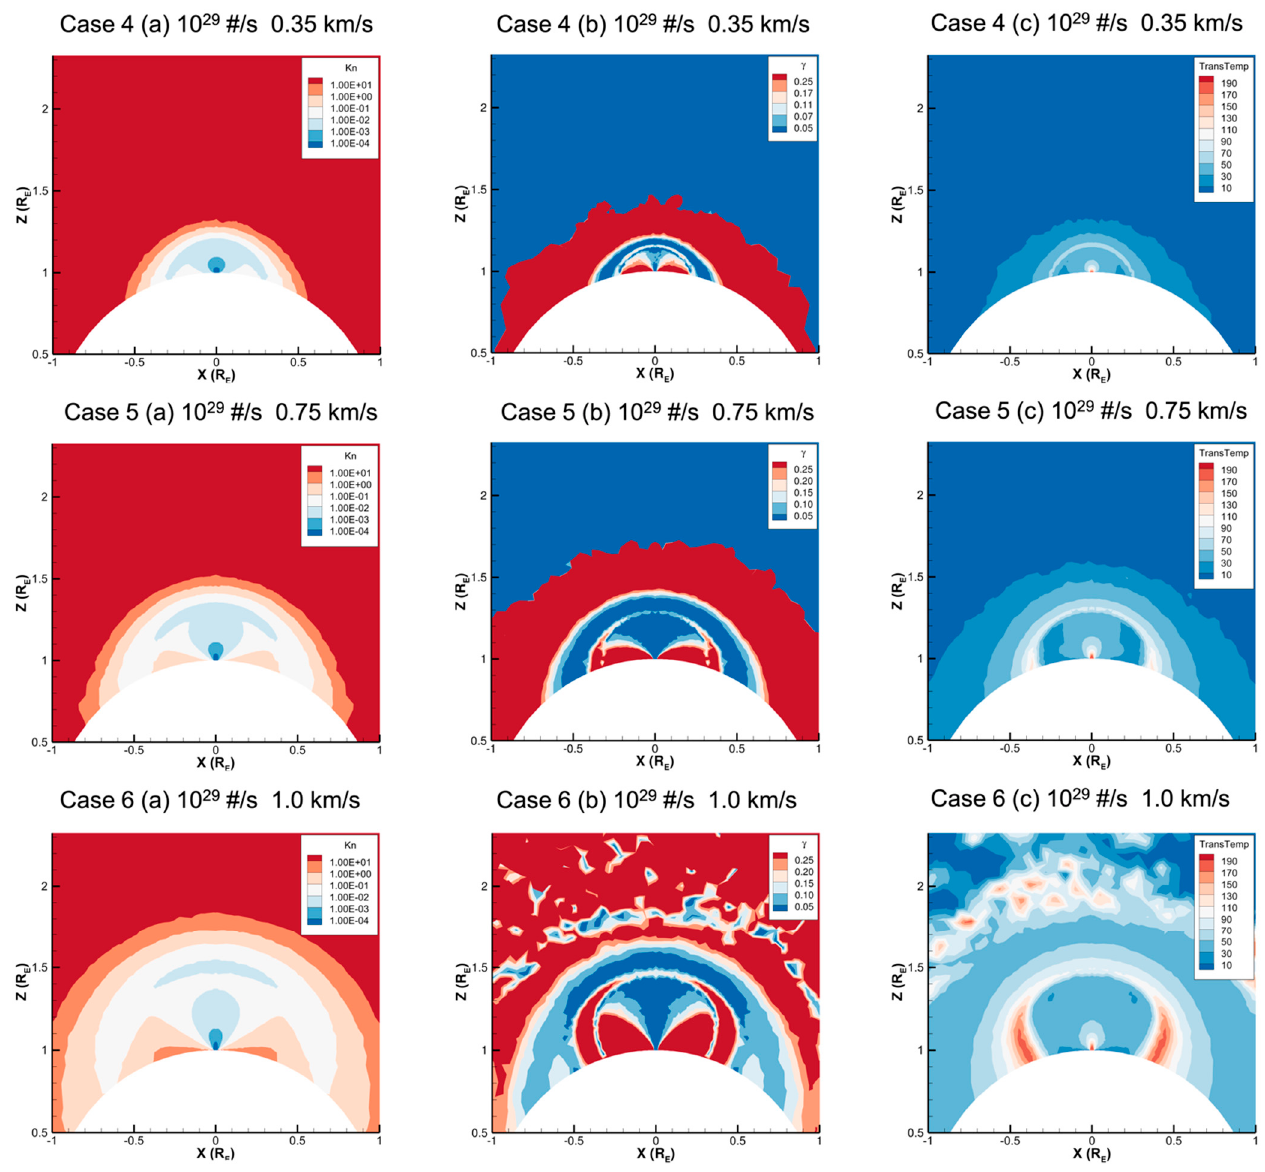
Figure 1. Column a ( Left ): Results of the local Knudsen number, K n (shown in contours with a color scale). When K n > ~0.01, the gas flow started to deviate from continuum. Column b ( Middle ): Degree of thermal equilibrium represented by γ (shown in contours with a color scale of γ ). γ is defined to be “the absolute value of (T trans /T rot ) minus 1”. A γ closer to 0 indicates that the gas flow is. approaching thermal equilibrium. Column c ( Right ): Gas translational temperature distribution (shown in contours with a color scale in units of K).